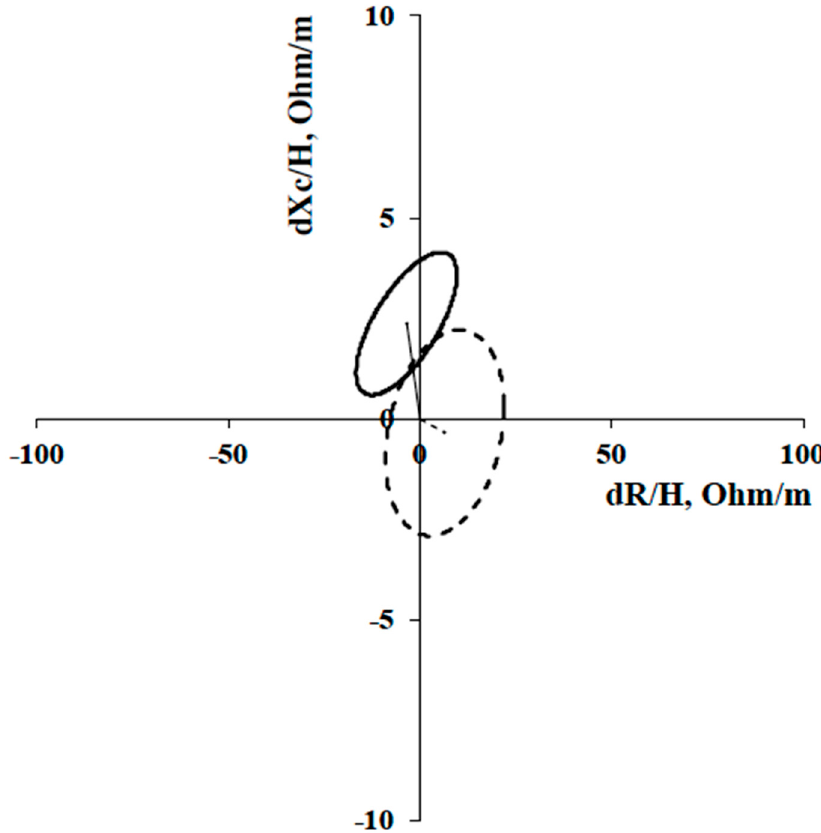
Figure 3. Paired Graph and impedance vector displacements with 95% confidence ellipses from before to after the intervention period. Continuous and dotted lines for the HIGH group and the LOW group, respectively. HIGH: the group with a high-weekly training frequency of three times a week; LOW: the group that performed only one weekly session.